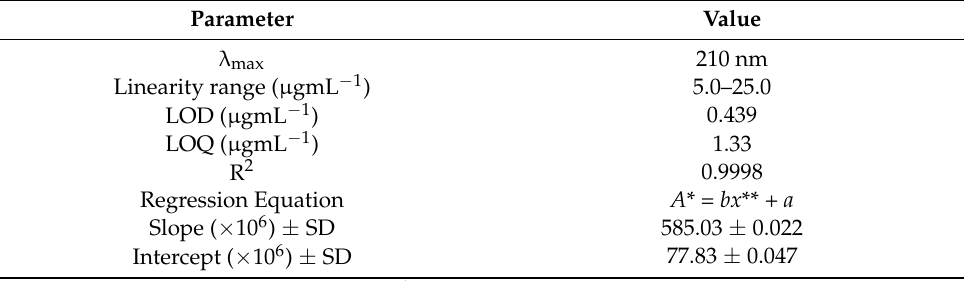
Table 4. Statistical parameters for the individual calibration curve.